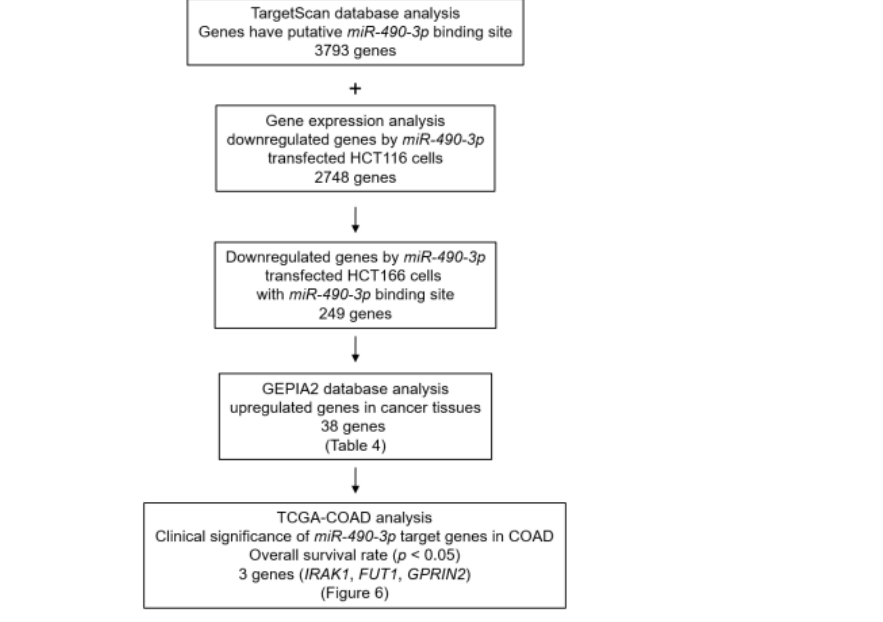
Figure 5. Flowchart for searching for oncogenic targets subject to miR-490-3p regulation in colorectal cancer (CRC) cells. To identify genes controlled by miR-490-3p in CRC cells, we used the TargetScan database and gene expression profile of miR-490-3p transfected HCT116 cells (GEO accession number: GSE129043). Moreover, GEPIA2 database analysis was used to identify upregulated genes in CRC tissues. A total of 38 genes were identified as possibly controlled by miR-490-3p in CRC cells. There were 38 candidate targets for miR-490-3p regulation in CRC cells (Table 2), of which three genes ( IRAK1 , FUT1 , and GPRIN2 ) were associated with poor prognosis (Figure 6). Among these targets, we focused on IRAK1 as an oncogenic target of miR-490-3p regulation in CRC